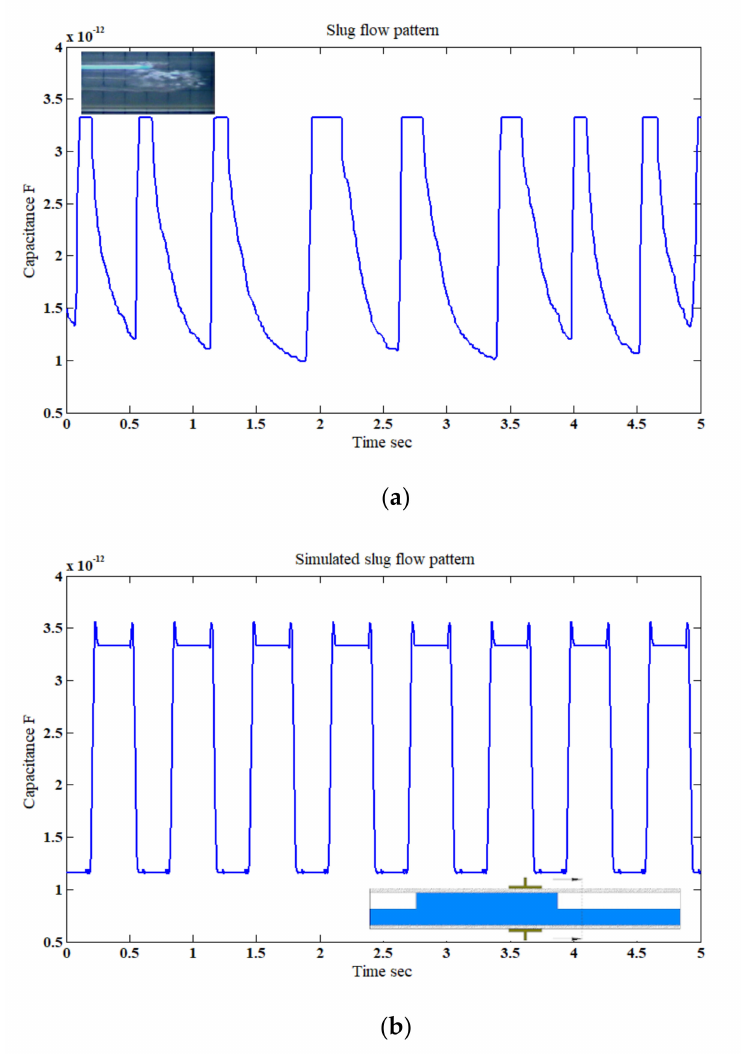
Figure 10. The time-dependent fluctuation of the capacitance value for the slug flow pattern: ( a ) experimental [32], and ( b ) simulation (for the superficial gas–liquid phase velocities of 0.8 m / s and 0.75 m / s, respectively; inclination angle β = 0 ◦